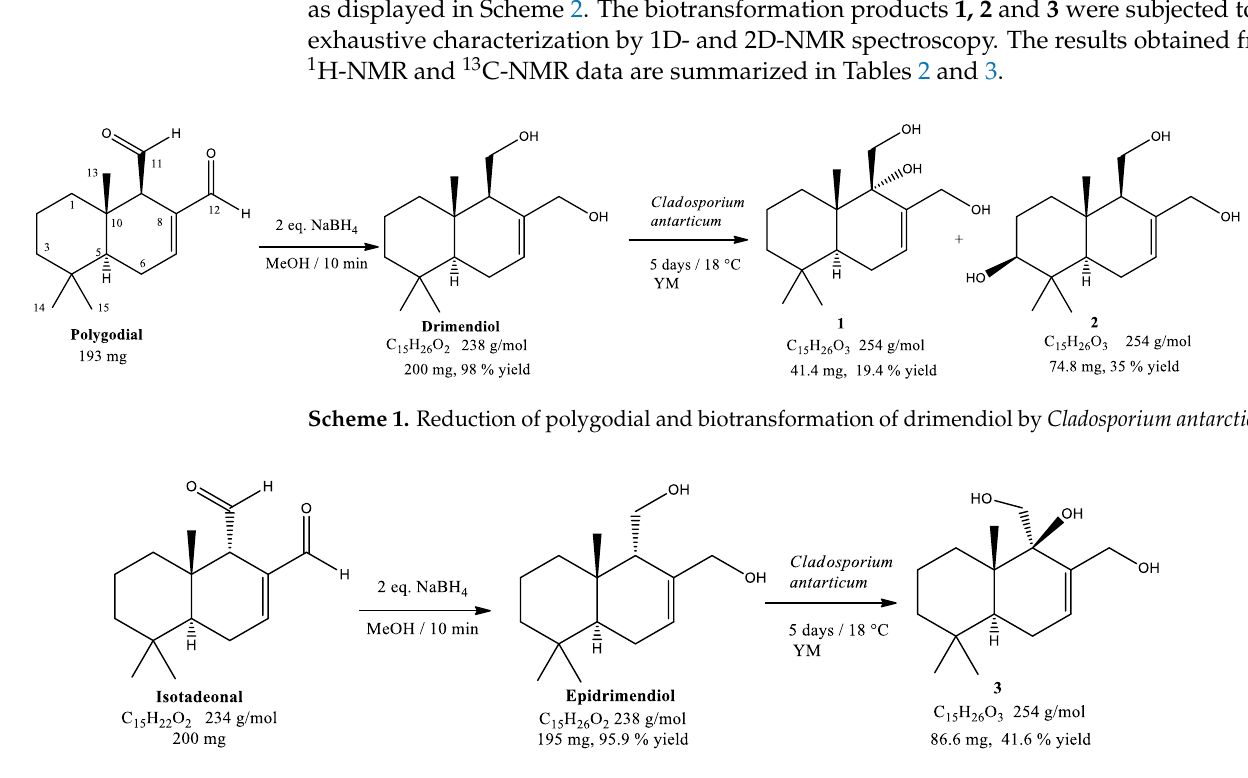
Scheme 2. Reduction of isotadeonal and biotransformation of epidrimendiol by Cladosporium antarcticum . Table 2. 1 H-NMR data for the biotransformation products 1 to 3 . Data were acquired at 400 MHz in acetone-d 6 . Chemical shift values ( δ ) are reported in ppm. Coupling constants ( J ) are reported in Hz. Hydrogen positions correspond to the labels provided in Scheme 1.